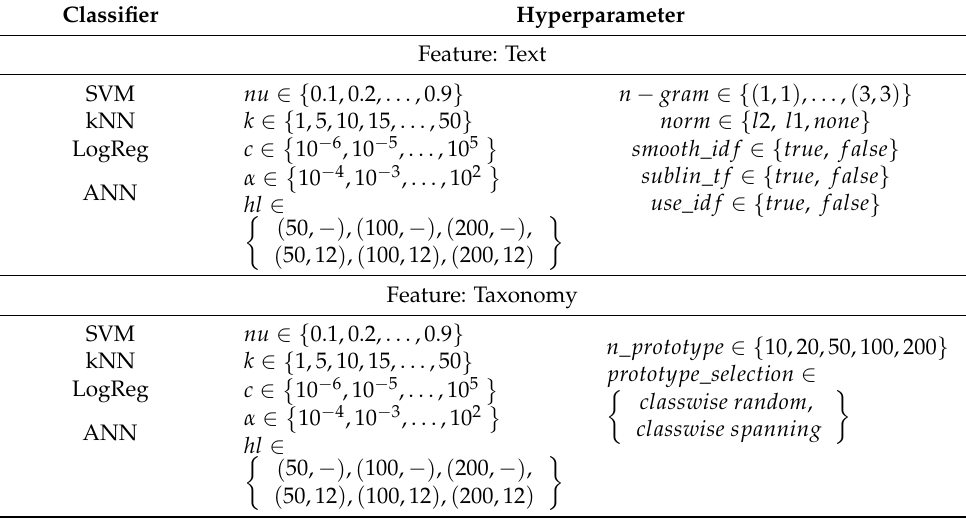
Table 3. Grid of hyperparameters to optimize the performance of the base classifiers acting on different textual and taxonomic features in 10-fold